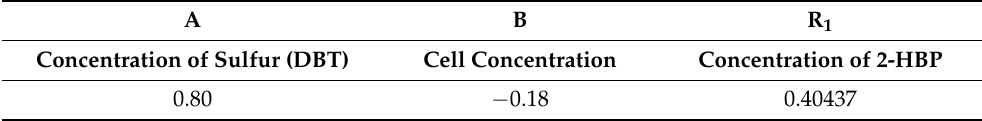
Table 4. Optimum conditions for R 1 response in the absence of the